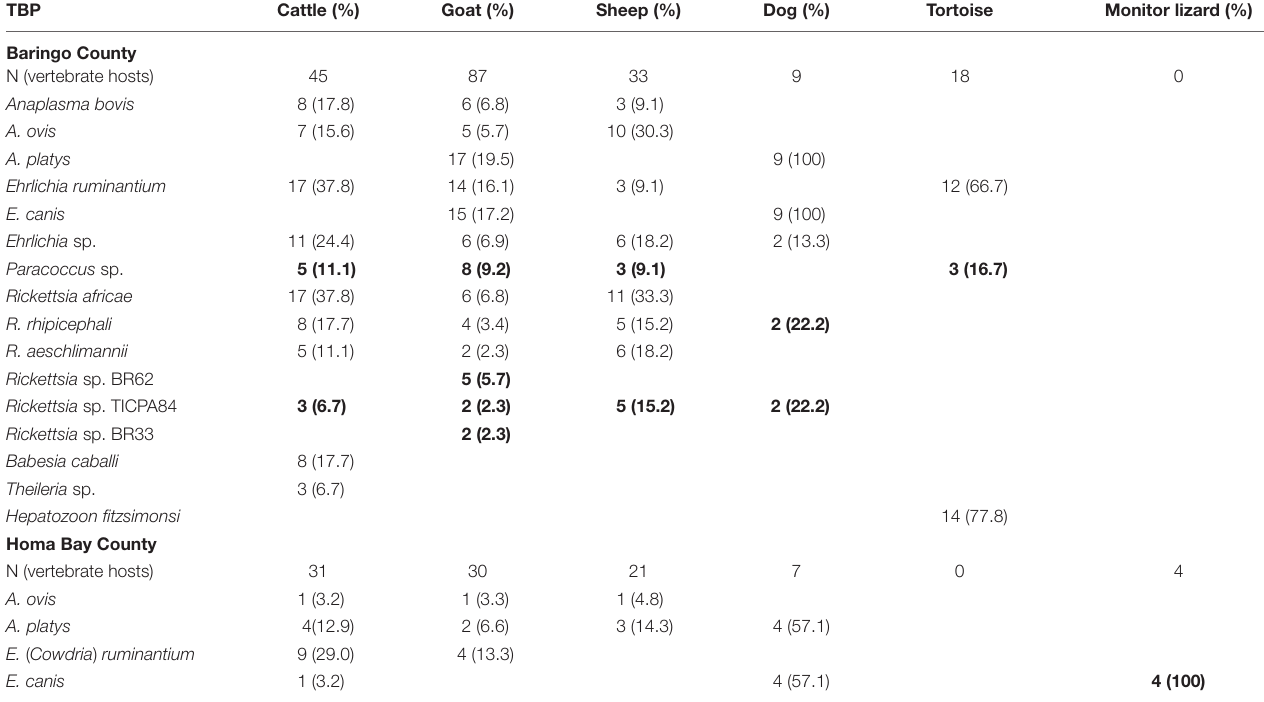
TaBle 6 | Vertebrate hosts from which ticks with tick-borne pathogens (TBPs) were isolated in the two study regions. TBP cattle (%) goat (%) sheep (%) Dog (%) Tortoise Monitor lizard (%)